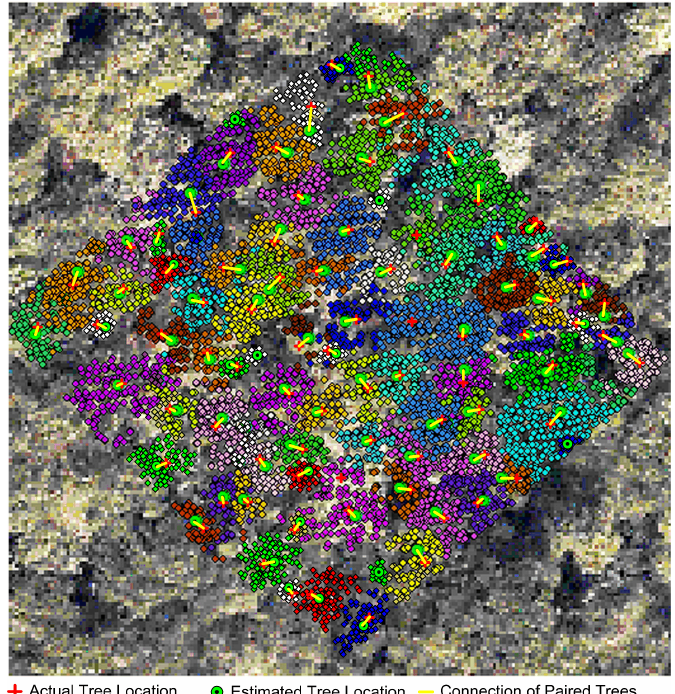
Figure 8. Digital orthophoto map overlaid with detected approximate positions of individual trees for a representative test subplot (DHS0401). A uniform colour is used to indicate the set of LiDAR (Light Detection And Ranging) points that are clustered as a given tree inside the measurement area.